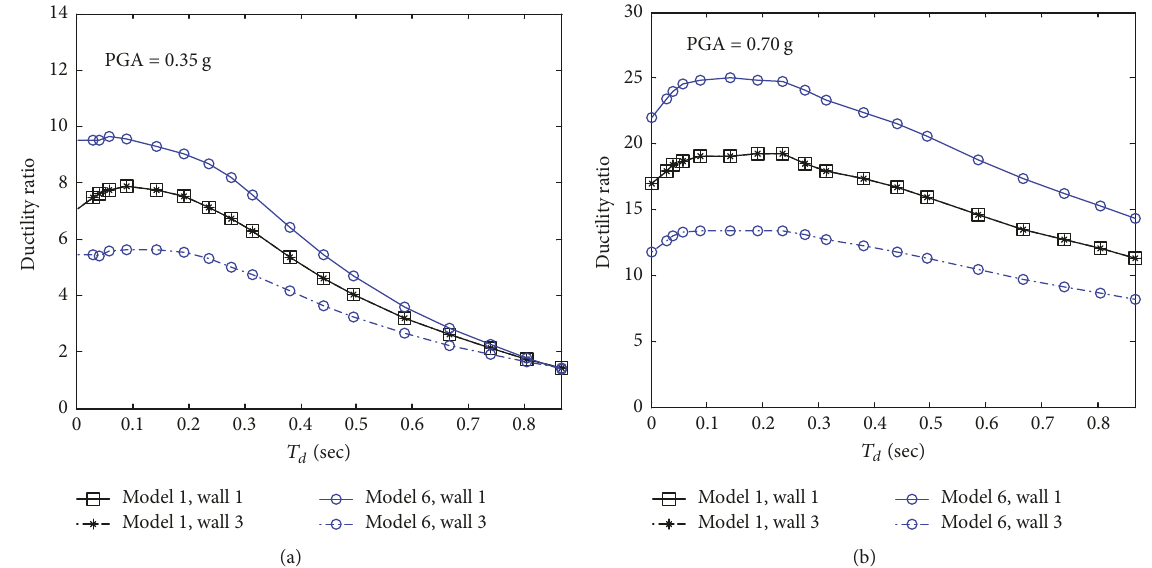
Figure 13: Ductility demands of stiff (wall 1) and flexible (wall 3) walls of the model 6: (a) DBE earthquakes (0.35 g) and (b) MCE earthquakes (0.70